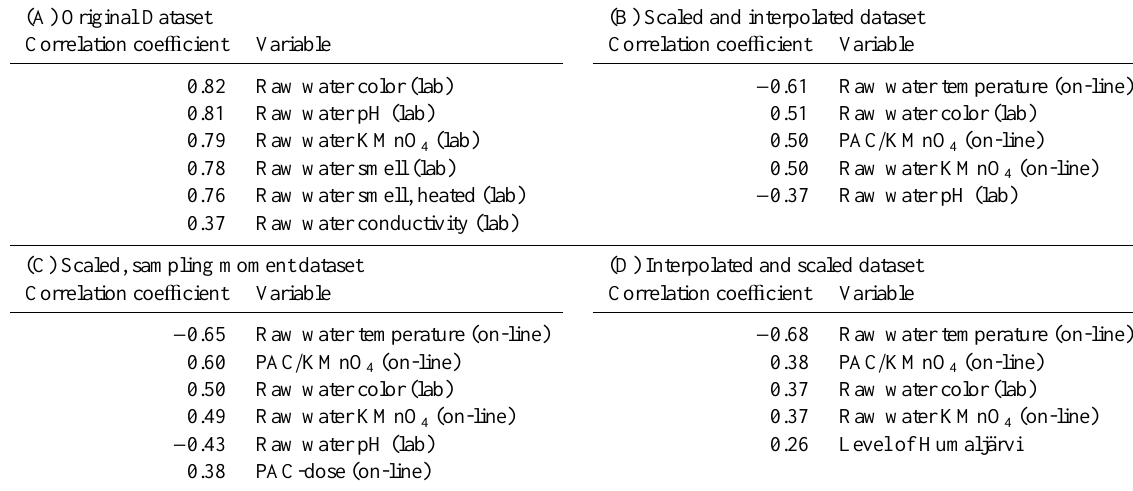
Table 1. Correlation coe ffi cients of the residual aluminum.